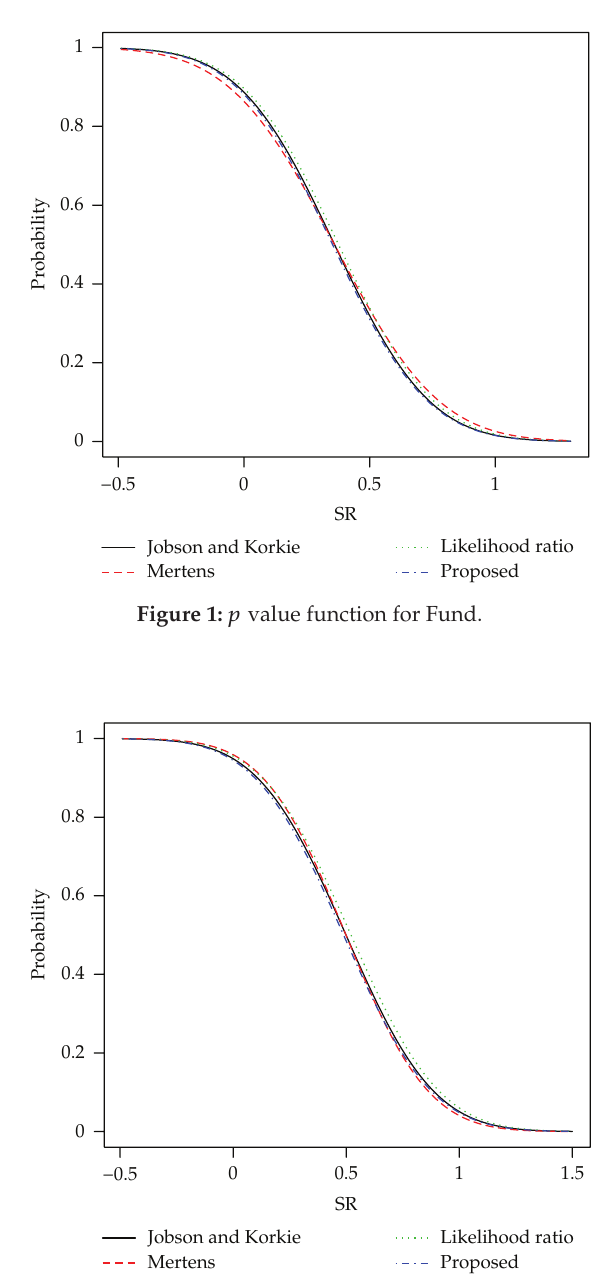
Figure 2: p value function for